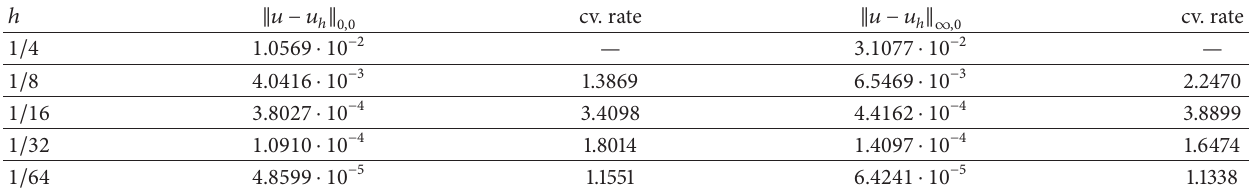
Table 1: The experiential error results and convergence rates of Example 1 (i).